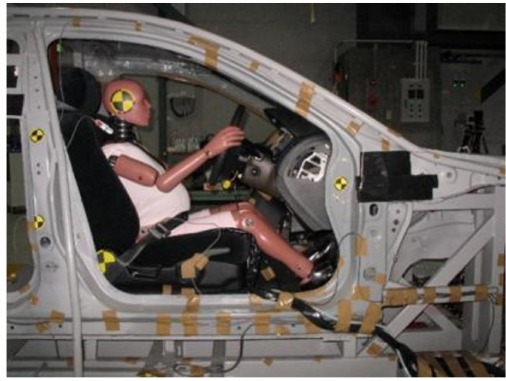
Figure 1. MAMA-2B AF05 ver. sitting in the test